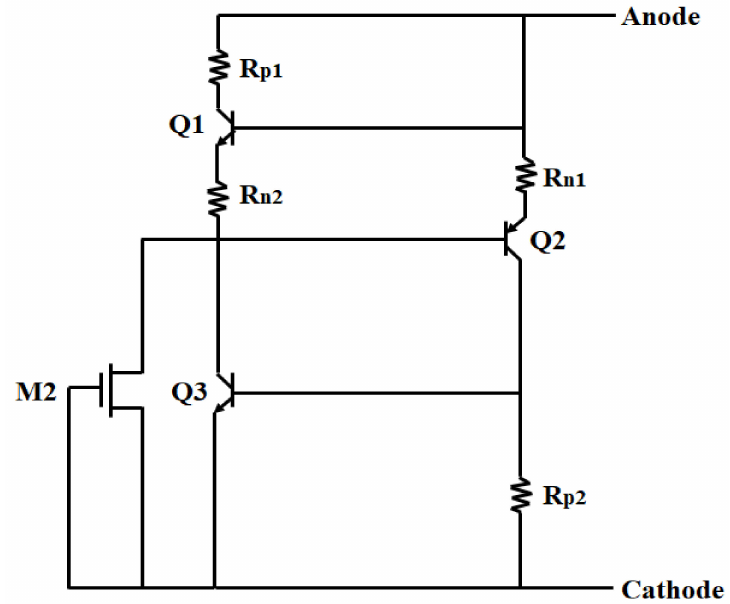
Figure 6. Equivalent circuit of SCR-based ESD protection